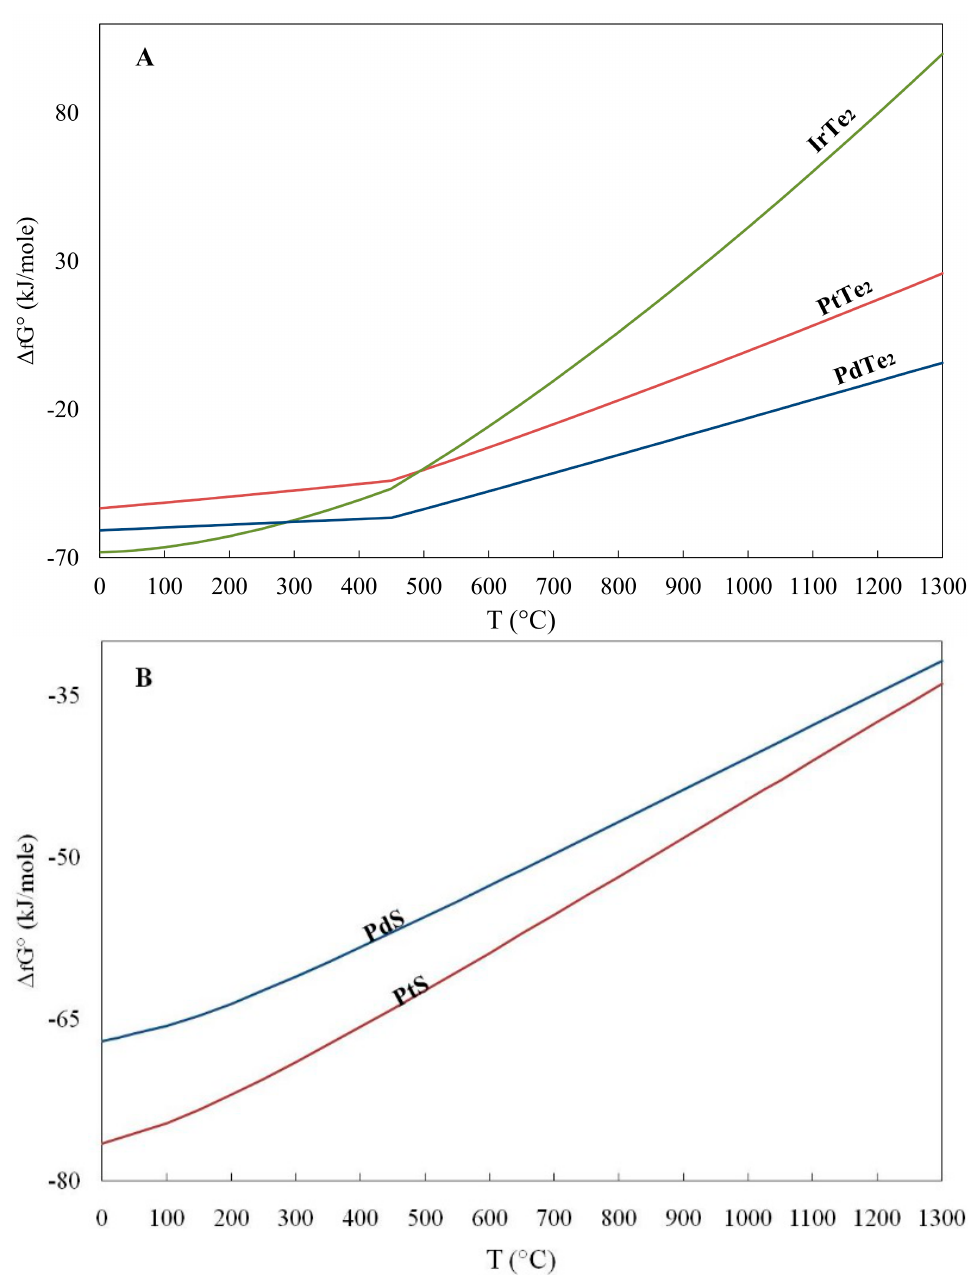
Figure 3. Plot of the Free energy ( Δ f G°) against temperature for ( A ) PtTe 2 (moncheite), PdTe 2 (merenskyite), IrTe 2 (shuangfengite) and ( B )PtS(cooperite) and PdS(braggite). Data from Table 4.